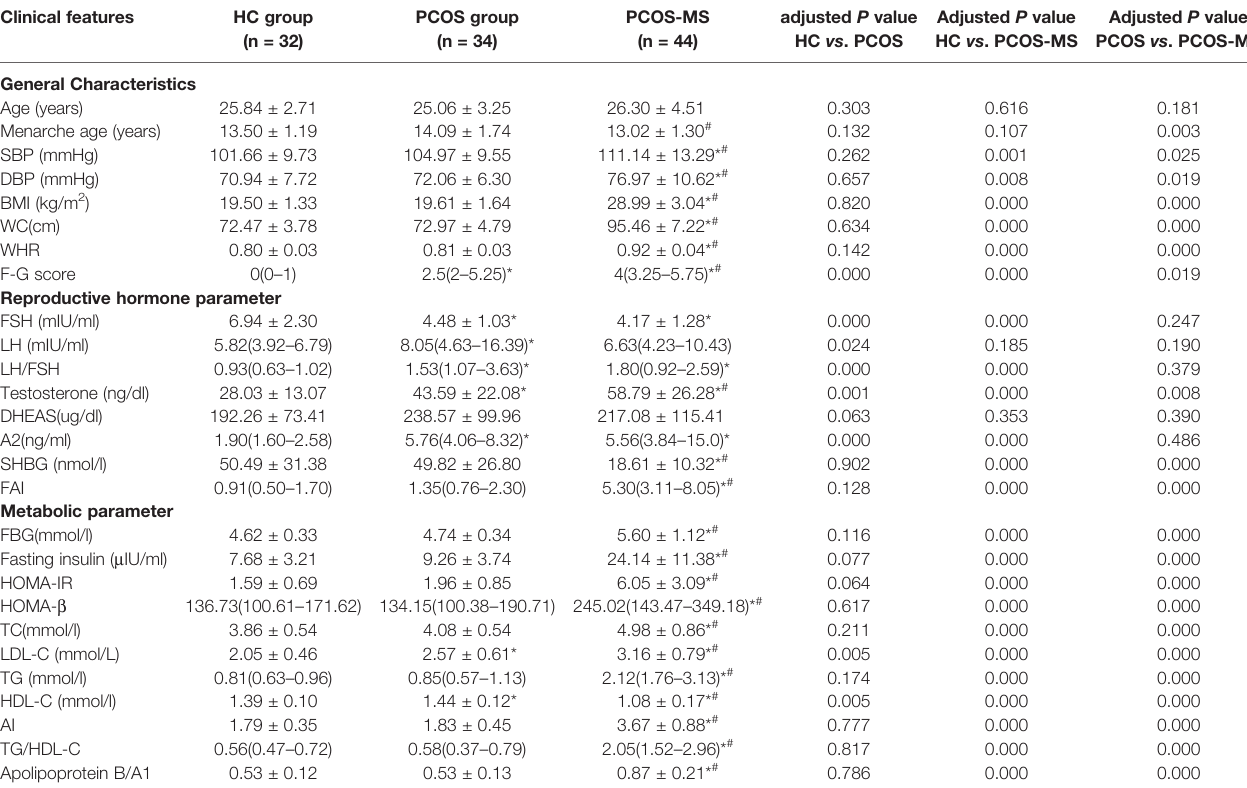
TABLE 1 | General characteristics, reproductive hormone and metabolic parameters among groups of HC, PCOS and PCOS-MS. Clinical